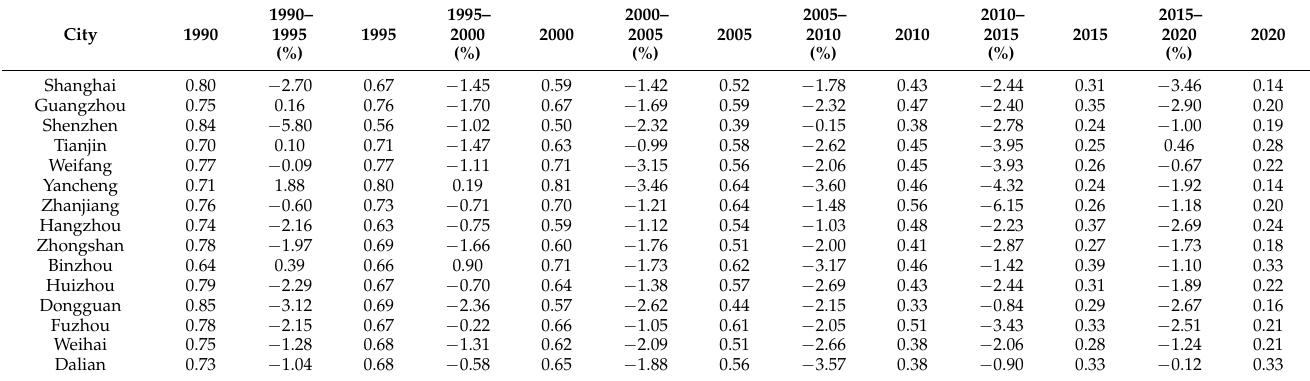
Table A4. The results of vulnerability and the change rate of each stage in 15 coastal cities from 1990 to 2020.